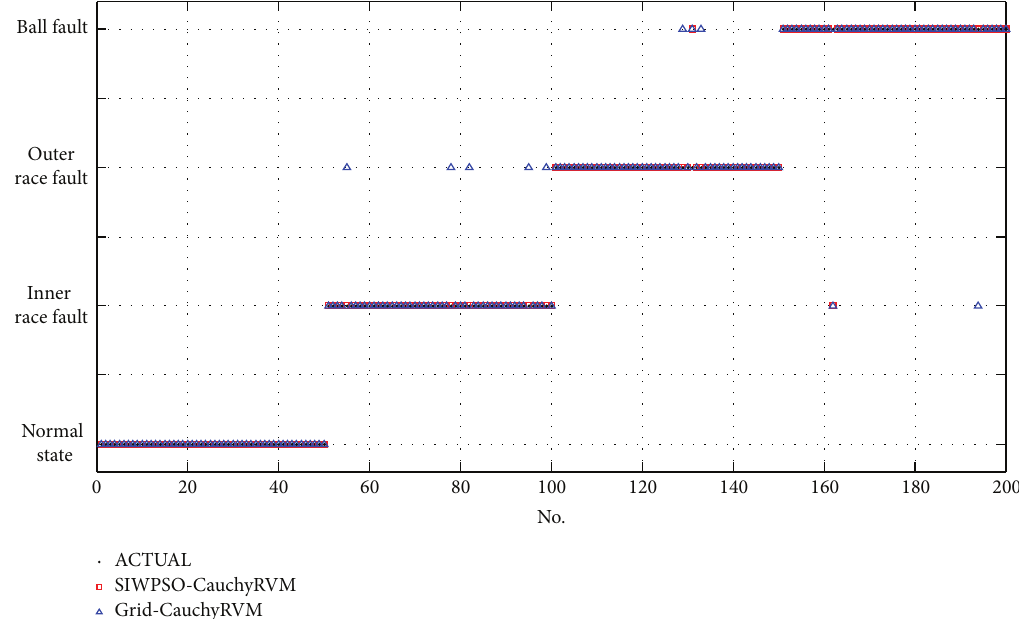
Figure 6: The comparison of the diagnosis results between SIWPSO-CauchyRVM and Grid-CauchyRVM in experiment 3.